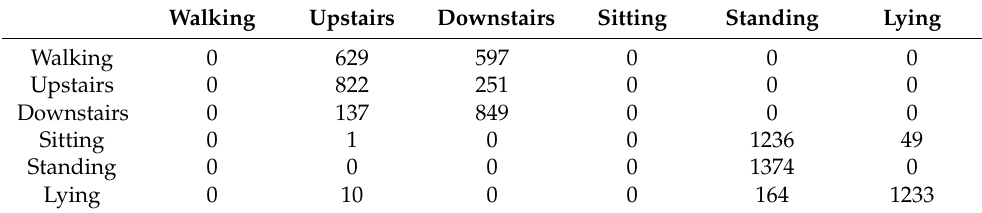
Table 2. Class confusion index on